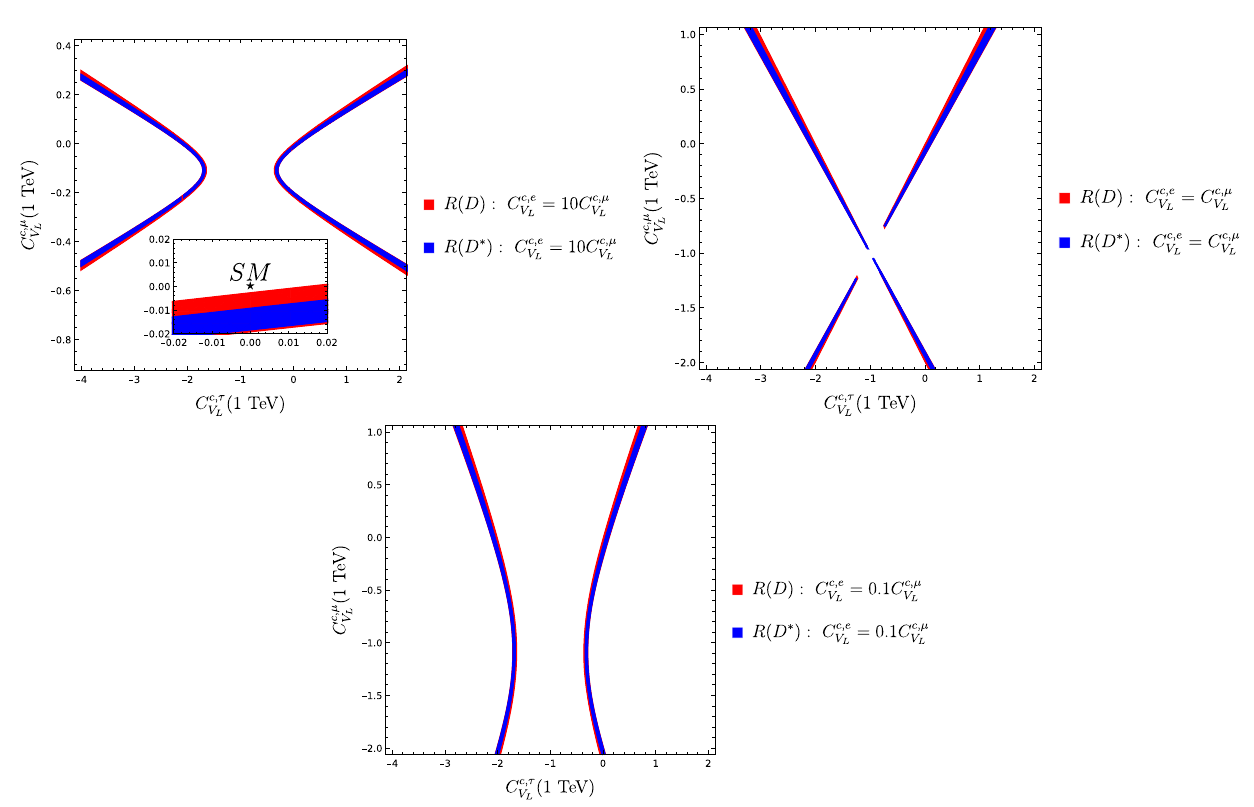
,μ – C c plane considering different correlations between the Wilson coefficients C c , e V L V L